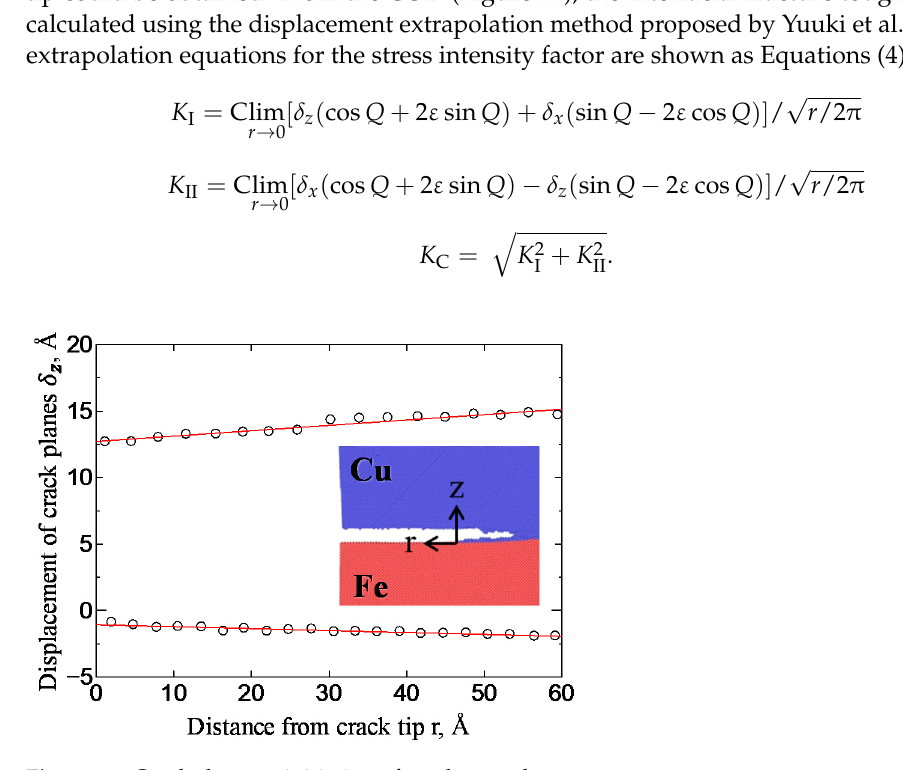
Figure 12. Crack shape at initiation of crack growth. Table 2. Fracture toughness values for each model in the molecular dynamics (MD) simulation.